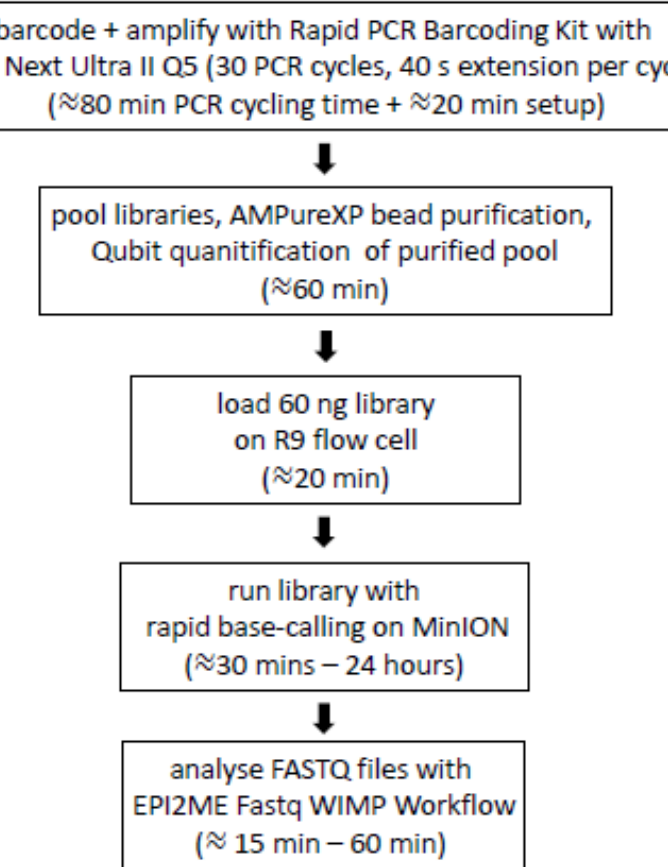
Figure 3. Outline of the protocol for the untargeted analysis of nasal DNA virome from nasal swabs of cattle using nanopore sequencing. Times indicated are from one person processing 12 samples in our laboratory (including a negative control). The image was created in Microsoft PowerPoint in Microsoft Office Professional Plus